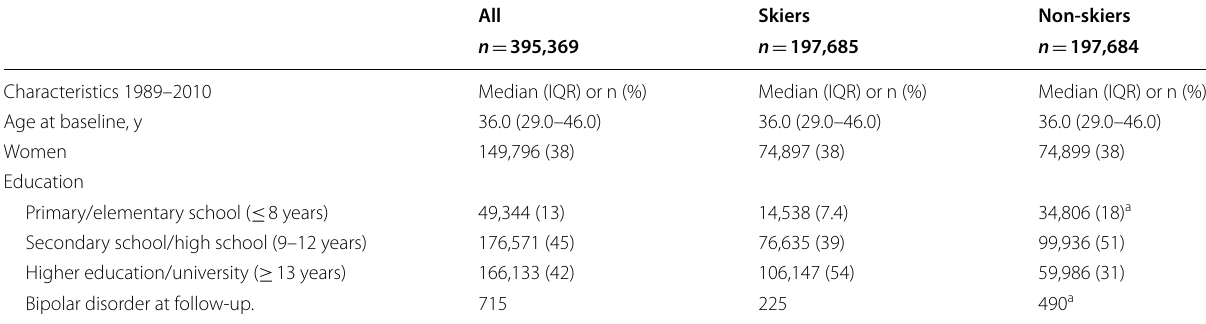
IQR interquartile range, y years, n numbers a p < 0 001. Group difference between skiers and non-skiers, estimated with Wilcoxon test (numeric variables) and Pearson’s χ 2 test (categorical variables). Only · significant differences are noted in the table